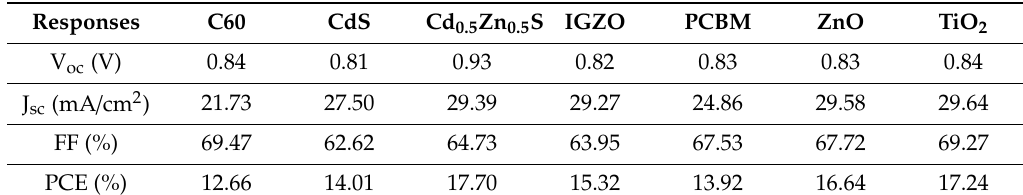
Figure 2. Effect of different ETL materials on J-V characteristics.